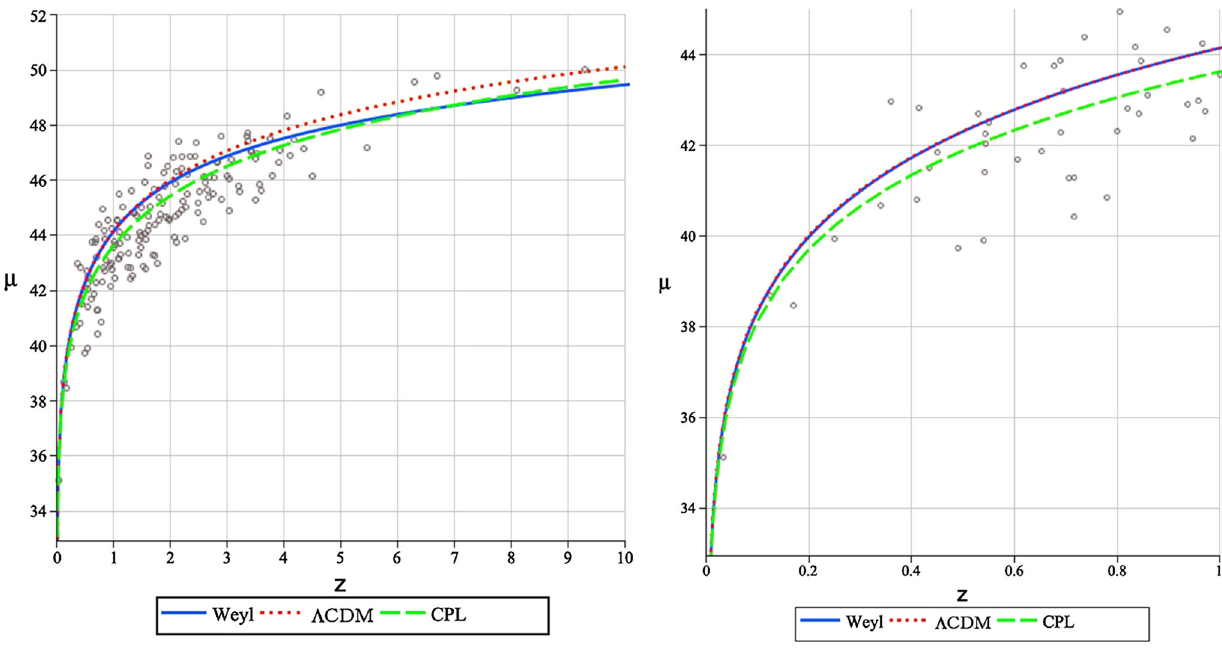
Polarski–Linder (CPL) parametrization [92] by choosing (cid:5) M = 0 . 24, (cid:5) (cid:3) = 0 . 76, w 0 = − 0 . 29, w 1 = − 0 . 12 and H 0 = 0 . 74 ( 100km / s / Mpc ) . The observation data (shown in gray points) is taken from the gamma-ray bursts (GRBs).